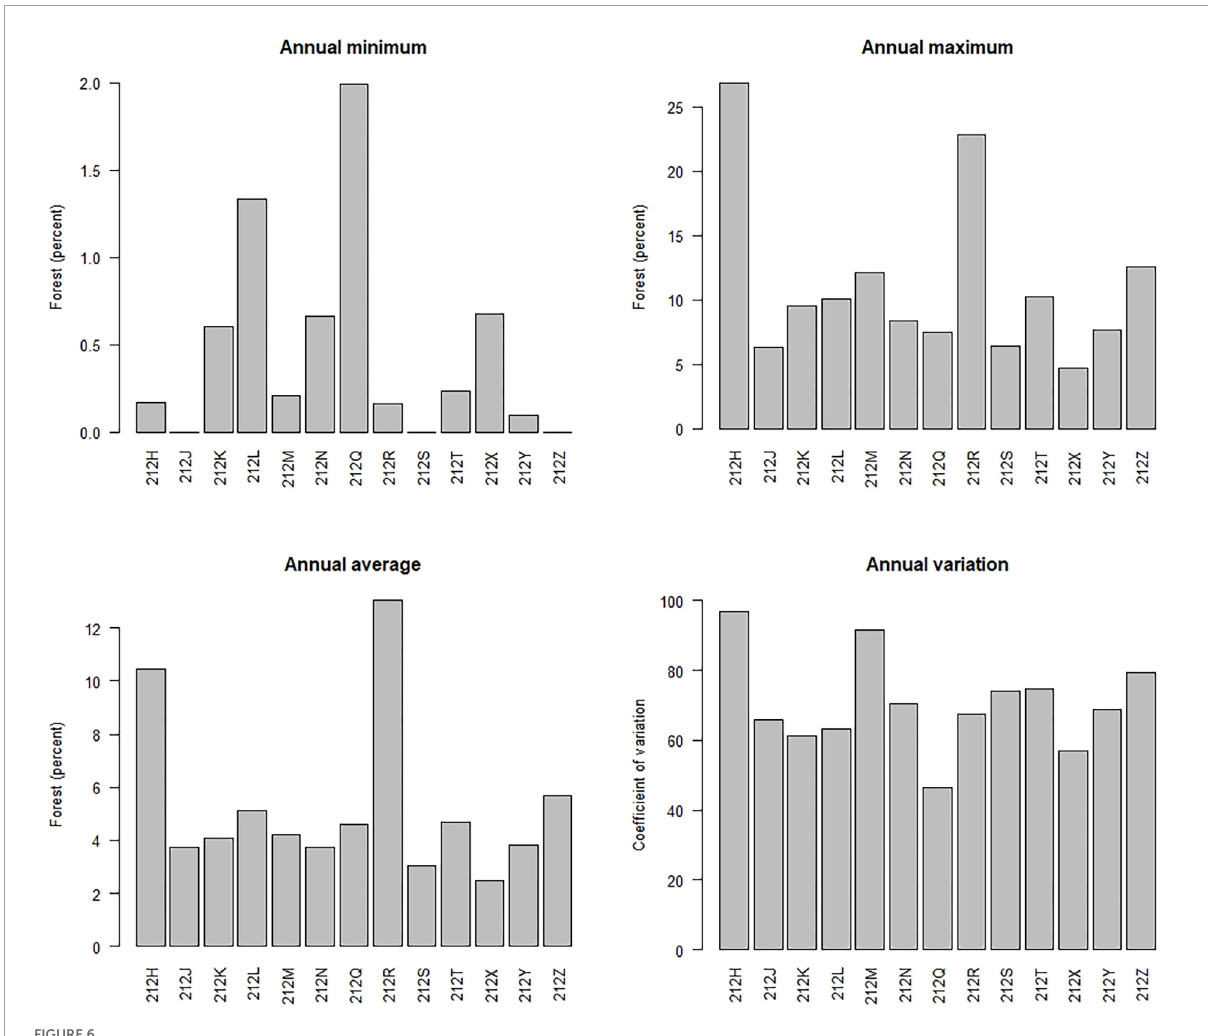
FIGURE6 Summaries of annual disturbance by ecological